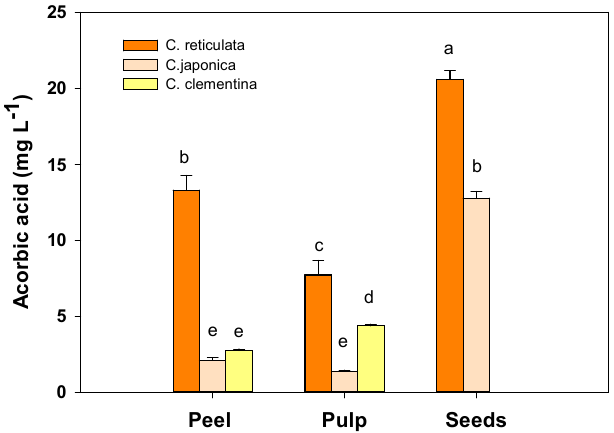
Figure 4. Total soluble antioxidant capacity expressed as ascorbic acid equivalents in peel, pulp and seeds in the three different tangerine cultivars: C. reticulata (Phlegrean mandarin), C. japonica (Kumquat) and C. clementina (Clementine). Each bar represents the mean ± SE ( n = 6). Different letters indicate statistically significant differences among mandarin varieties ( p < 0.05). Results were analysed by one-way ANOVA followed by Holm–Sidak post hoc test for multiple comparisons.